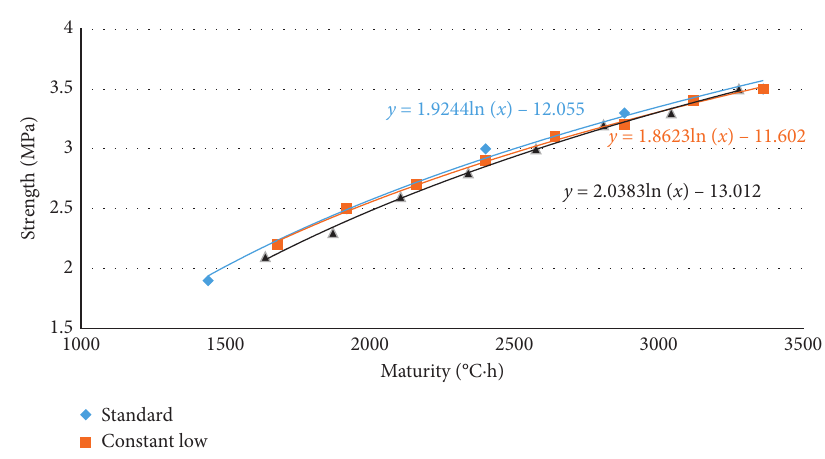
Figure 12: Relationship between maturity and strength. Table 6: The compressive strength of tested and predicted outdoor